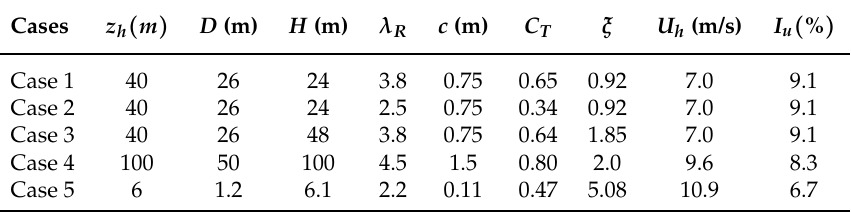
Table 1. Key characteristics of the wind turbines and the incoming wind.